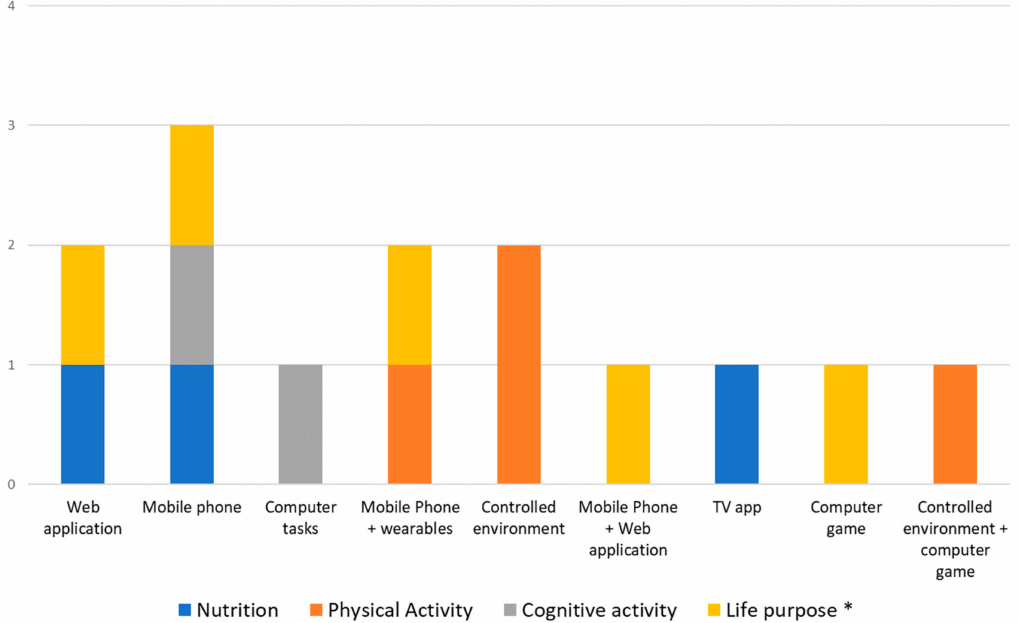
Figure 6. Technologies applied for monitoring and intervention on each pillar. *Life purpose includes studies focused on behavior and behavioral